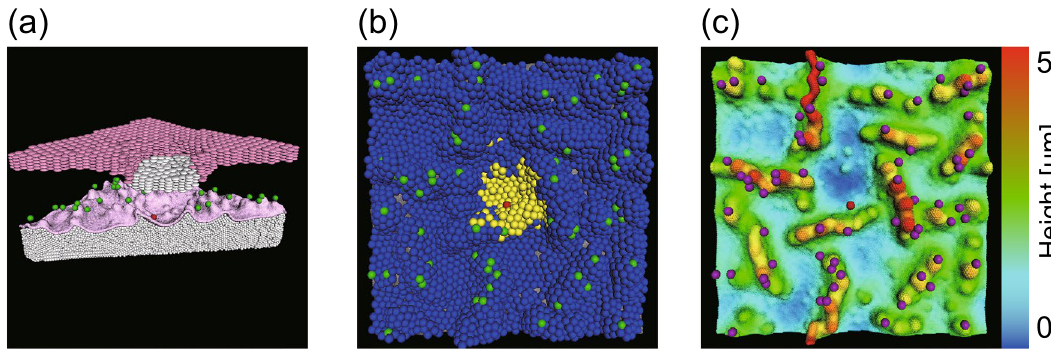
Figure 5. Simulation for the formation of a corn. ( a ) Cross-section. One stem cell (red) has an abnormality among normal stem cells (green). Cornified cells are colored white when produced from the abnormal stem cell and pink when produced from normal stem cells. ( b ) Top view of the basal layer. Yellow and blue cells are transit-amplifying (TA) cells that are originated from the abnormal stem cells and normal stem cells, respectively. ( c ) Top view of the basement membrane. The color indicates the vertical displacement of the baement membrane, measured from the lowest point. Stem cells are colored violet.